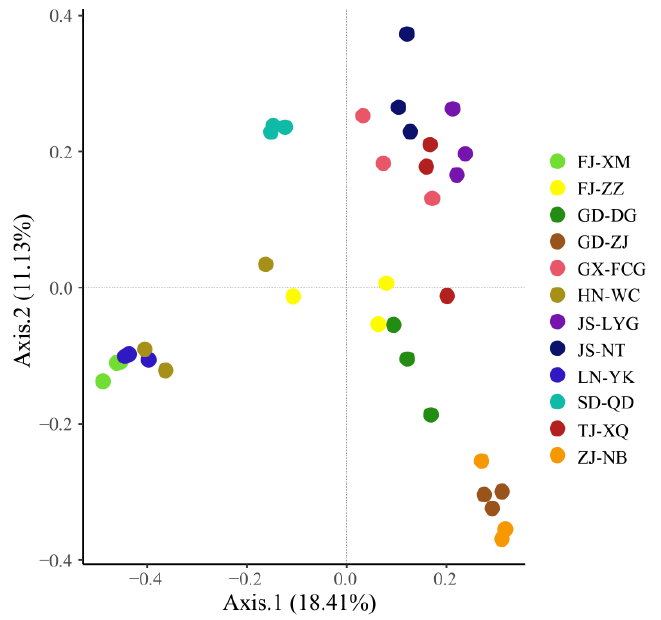
Figure 2. Beta diversity (PCoA of the intestinal bacterial community at the OTU level) of intestinal bacteria among different samples.